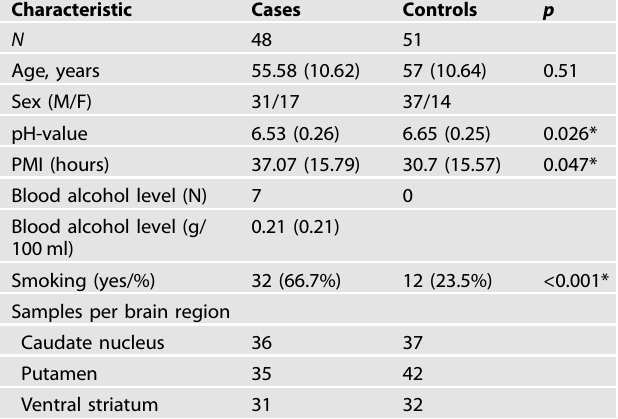
Table 1. Descriptive statistics of demographic